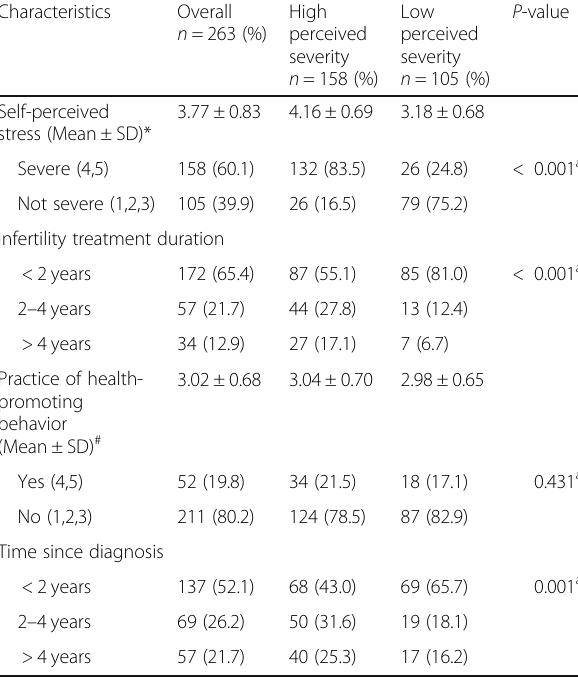
Table 6 Multivariate logistic regression analysis between demographic, health behavior, and reproductive